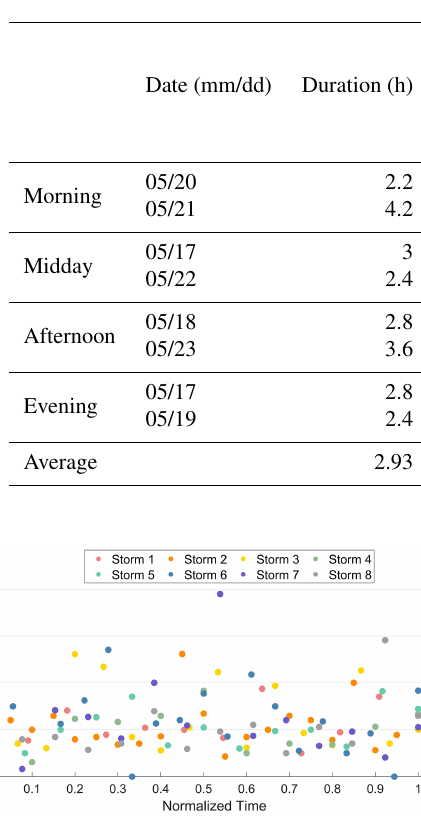
Table 3. Parameters to characterise thunderstorms of eight cases.